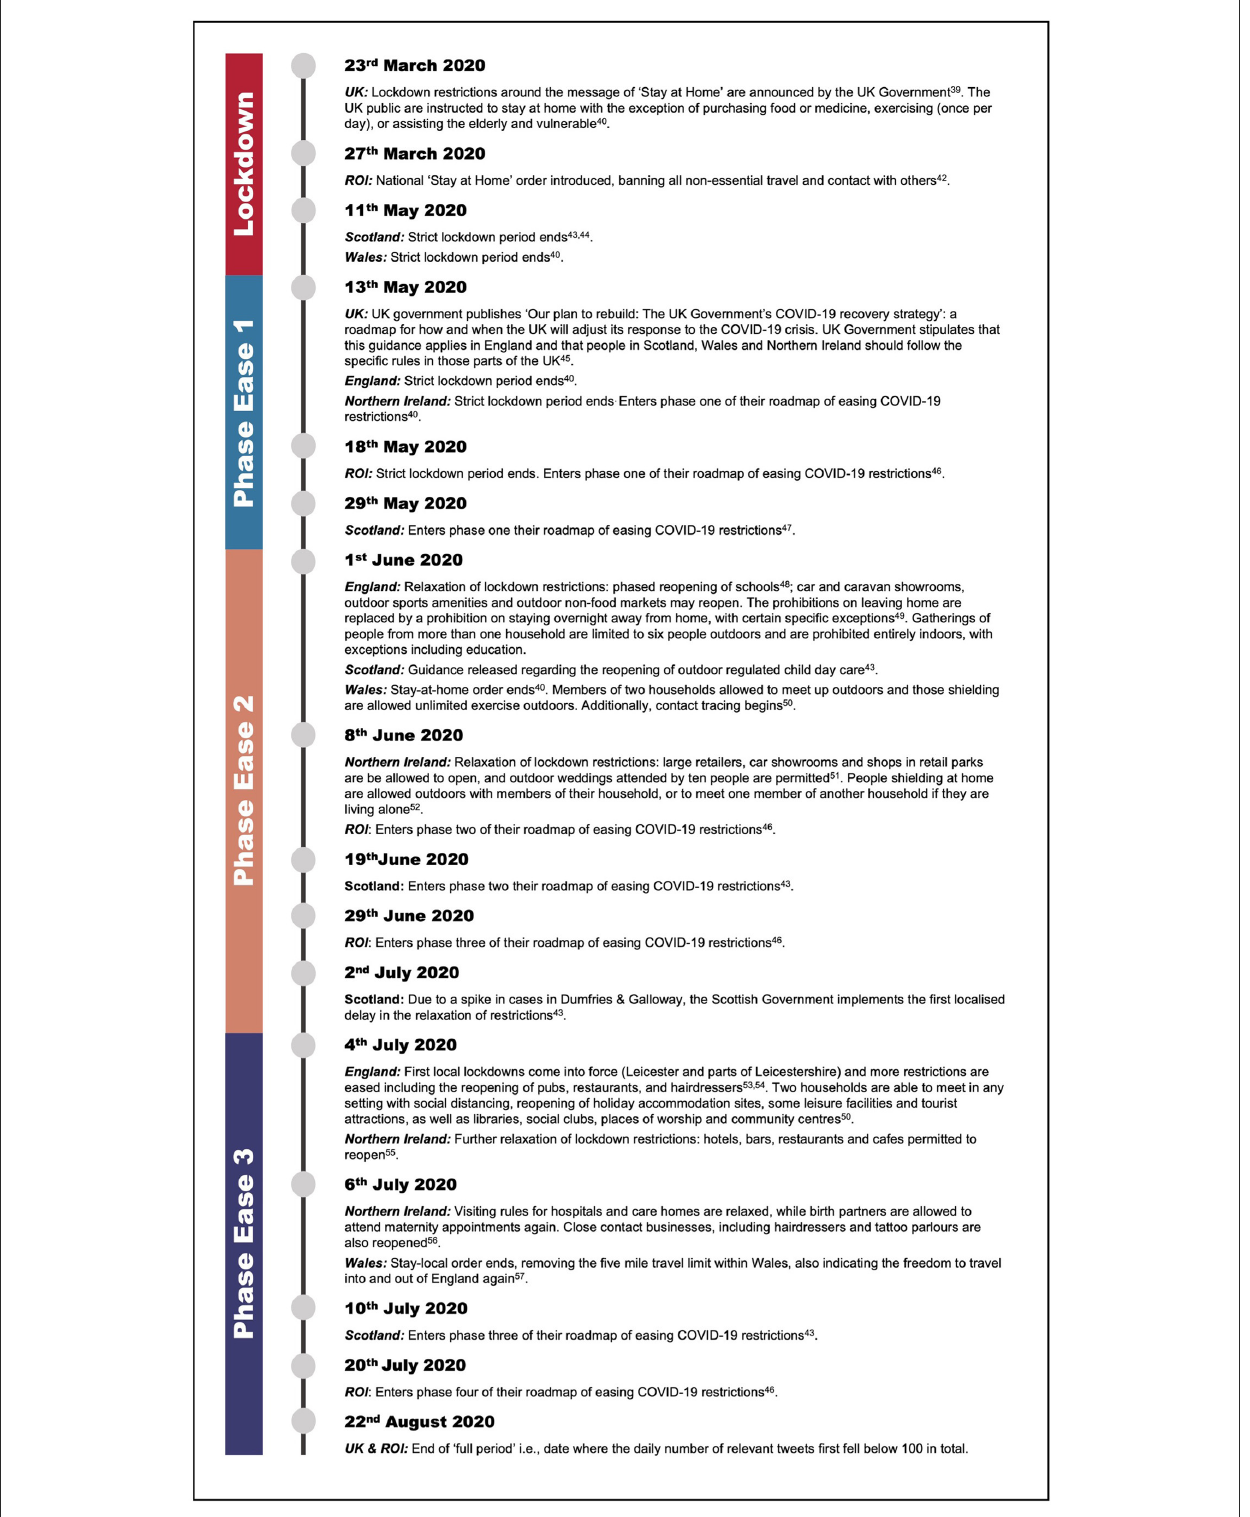
FIGURE1 Dates of major events occurring across the UK nations (England, Northern Ireland, Wales, and Scotland) and Republic of Ireland (ROI), during the full period (March 27th – August 22nd, 2020), which are relevant to determining the four pandemic phases [Lockdown, Phase Ease 1, Phase Ease 2, and Phase Ease (39, 40,